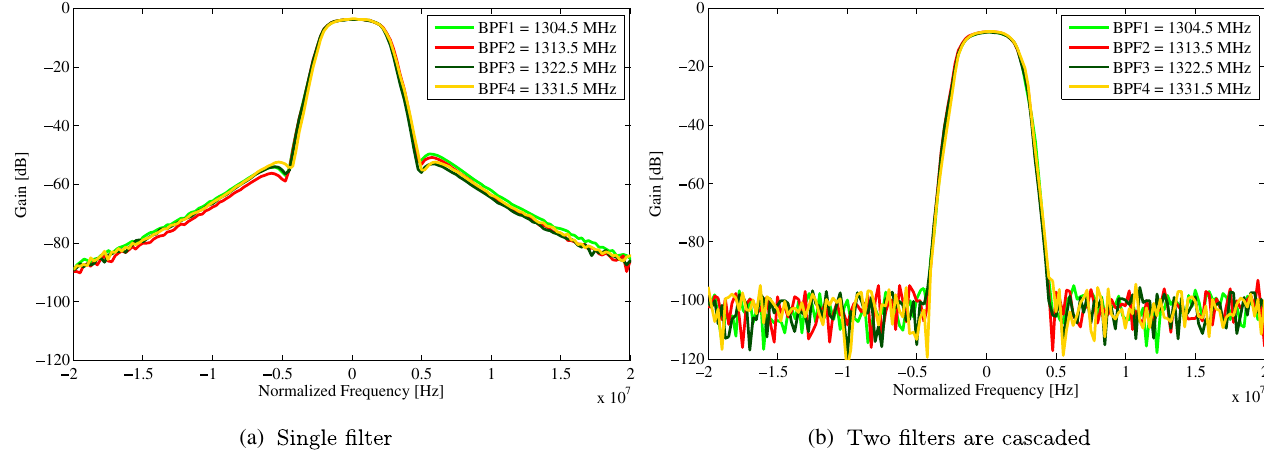
FIG. 7. Frequency response of the BPF for LO generation. The center frequencies are normalized and the bandwidth of all filters is 4 MHz.